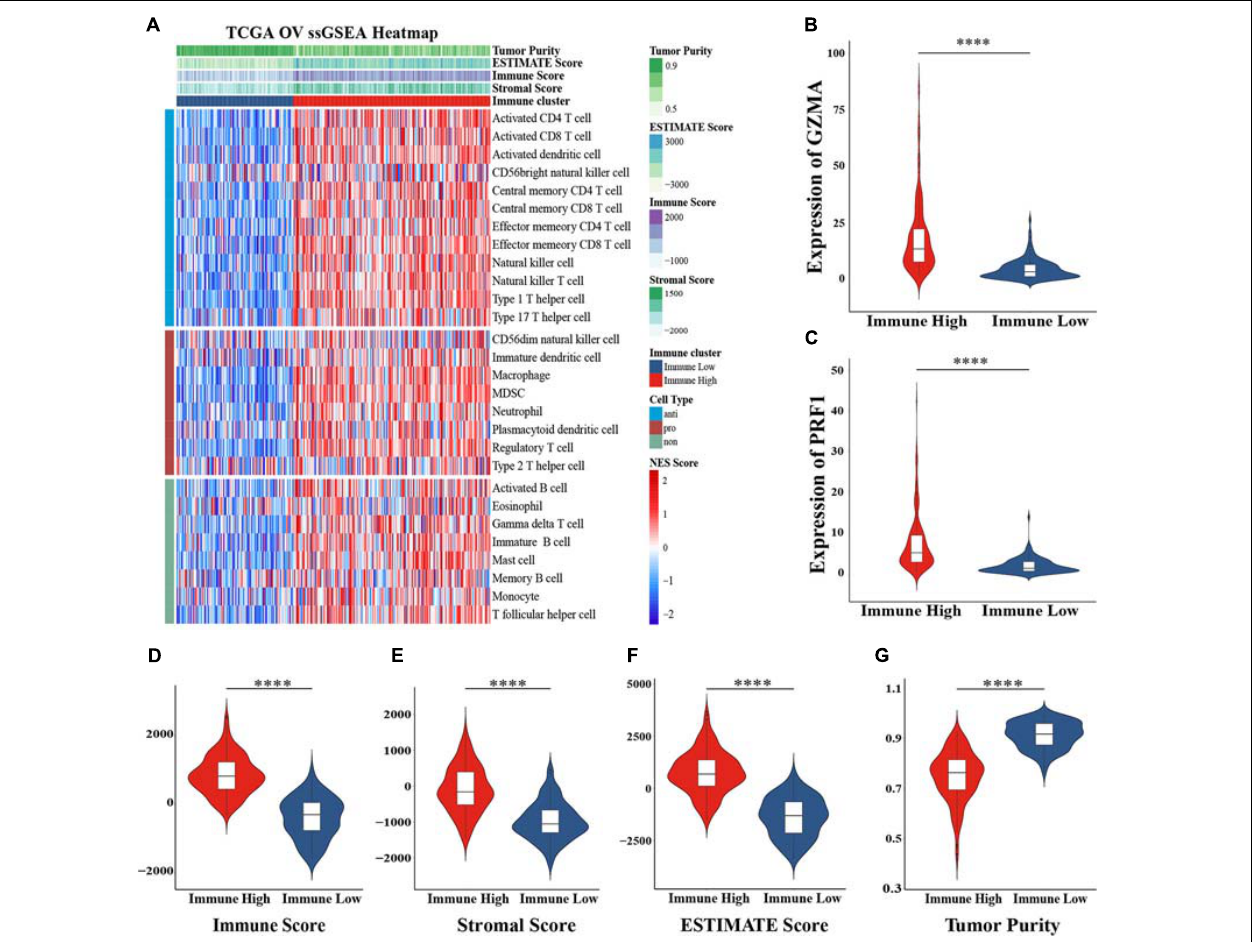
FIGURE 1 | Construction of immune-related clusters and exploration heterogeneity of components. (A) Clusters were constructed in The Cancer Genome Atlas (TCGA) cohort determined by ssGSEA and unsupervised hierarchical clustering analysis, and heterogeneity was explored by the ESTIMATE algorithm. Violin plots showed the immune cytolytic activity between the expression of GZMA (B) and PRF1 (C) between two clusters. Distribution of immune score (D) , stromal score (E) , ESTIMATE score (F) , and tumor purity (G) in the “Immune High” cluster and the “Immune Low” cluster indicated heterogeneity between two clusters. NES, normalized enrichment score; **** p <